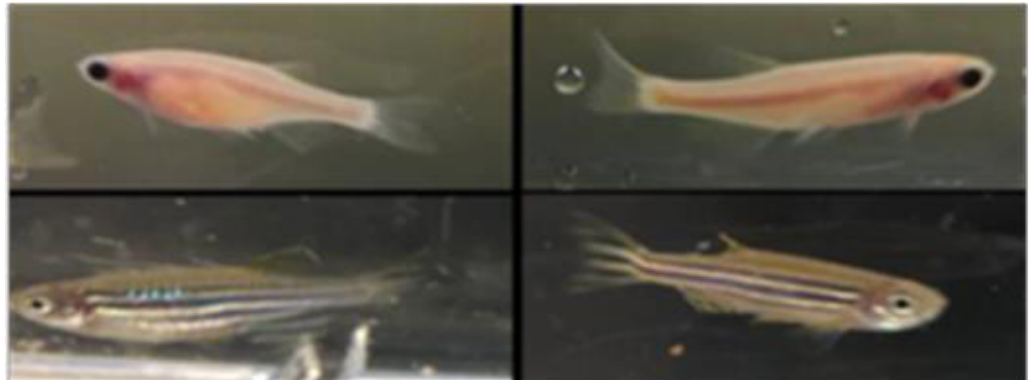
Figure 1. The zebrafish that portray the wild-type pigmentation (stripes). The right panels are the male zebrafish (darker blue stripes) and the left panels are the female zebrafish (rounder belly). Upper panels are Casper (roy −/− ,nacre −/− ) fish and lower panels are transgenic lines; cardiomyocyte/annexin-5 transgenic Tg(UAS:SEC-Hsa.ANXA5-YFP,myl7:RFP) having normal skin pigmentation pattern.